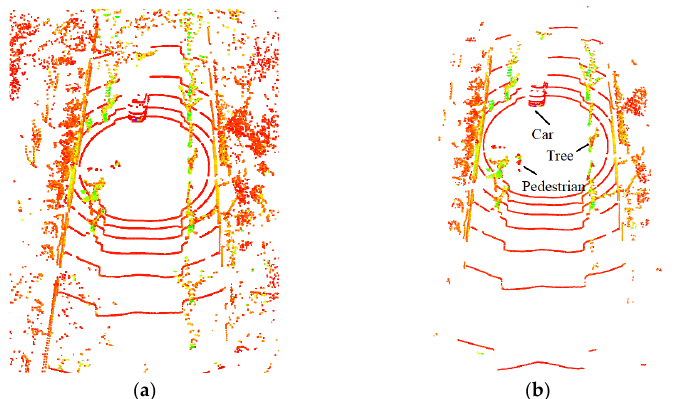
Figure 1. Interference point removal: ( a ) point cloud before interference point removal; ( b ) point cloud after interference point removal.